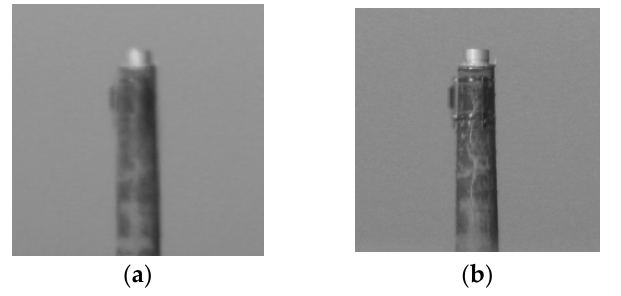
Figure 1. Video frames with and without air turbulence effects. ( a ) A frame with turbulence; ( b ) A frame without